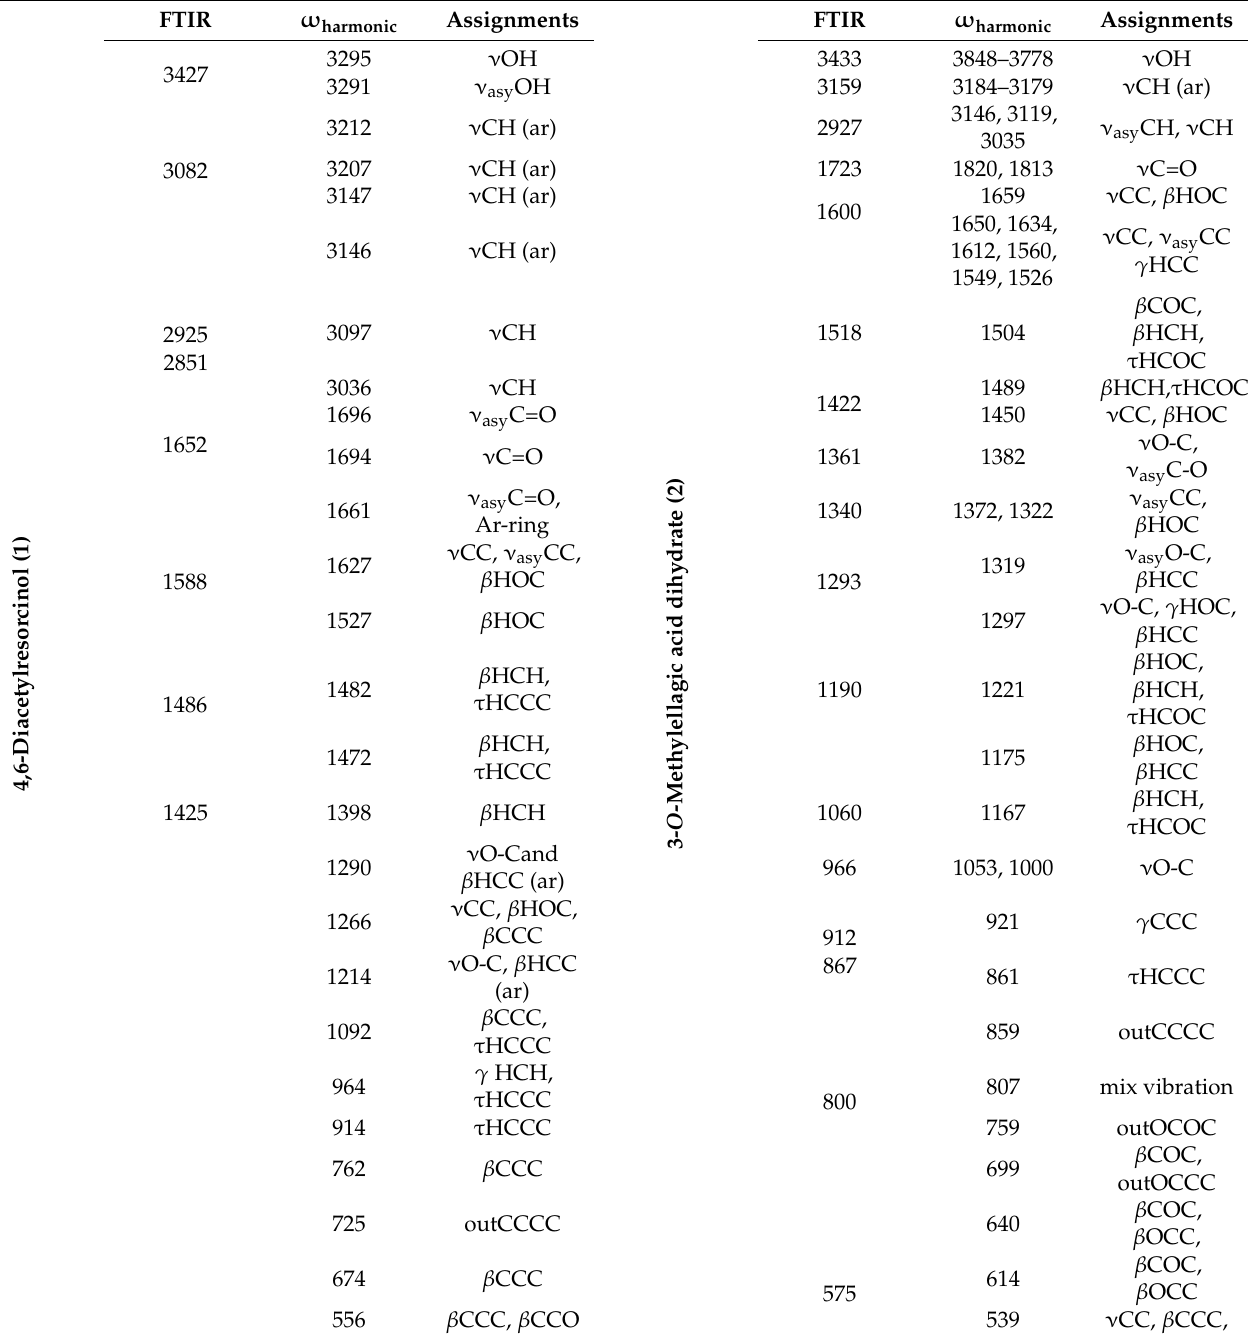
Table 2. Experimental and theoretical IR frequencies (in cm − 1 ) along with IR intensity (in km/mol) and vibrational assignments of compound 1 and 2 . FTIR ω harmonic Assignments FTIR ω harmonic